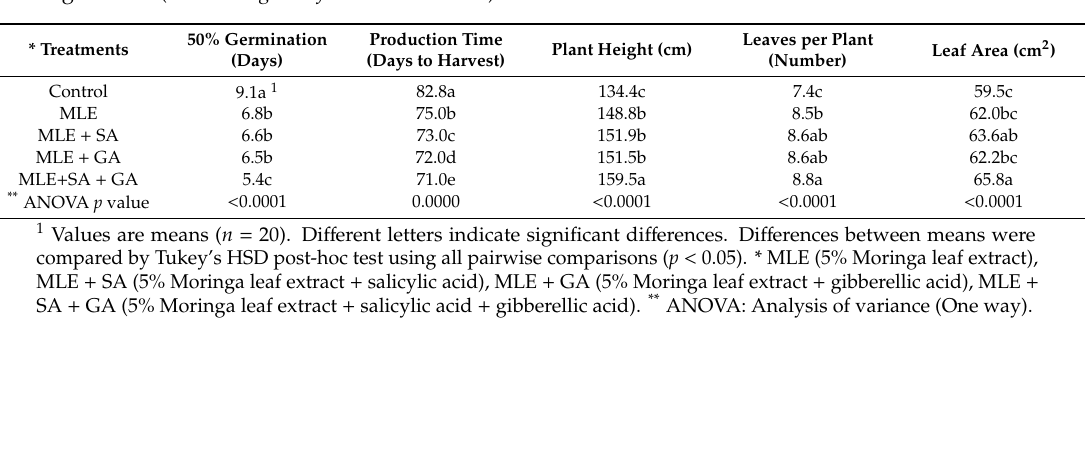
Table 1. E ff ect of 24 h corm soaking on time to 50% germination, production time, and vegetative traits of gladiolus ( Gladiolus grandiflorus cv.